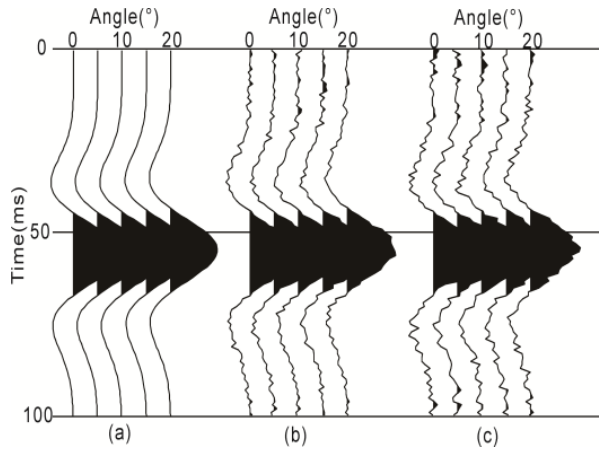
Figure 8. Seismic traces of Model 3: ( a ) 0% noise; ( b ) 10% white noise; ( c ) 20% white noise.